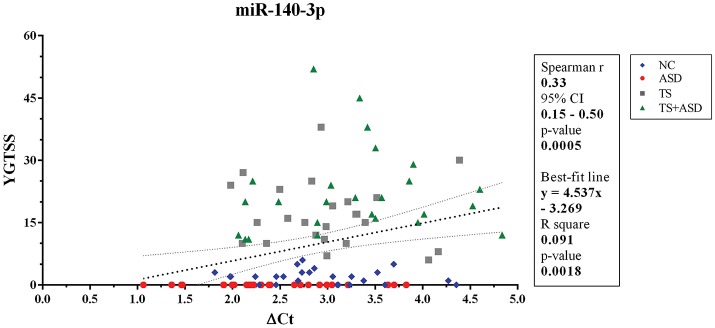
Correlation between serum levels of miR-140-3p and scores from YGTSS scale. The scatterplot refers to all the 104 analyzed samples and it also reports the best-fit line obtained from linear regression analysis. YGTSS, Yale Global Tic Severity Scale; 95% CI, 95% Confidence Interval.